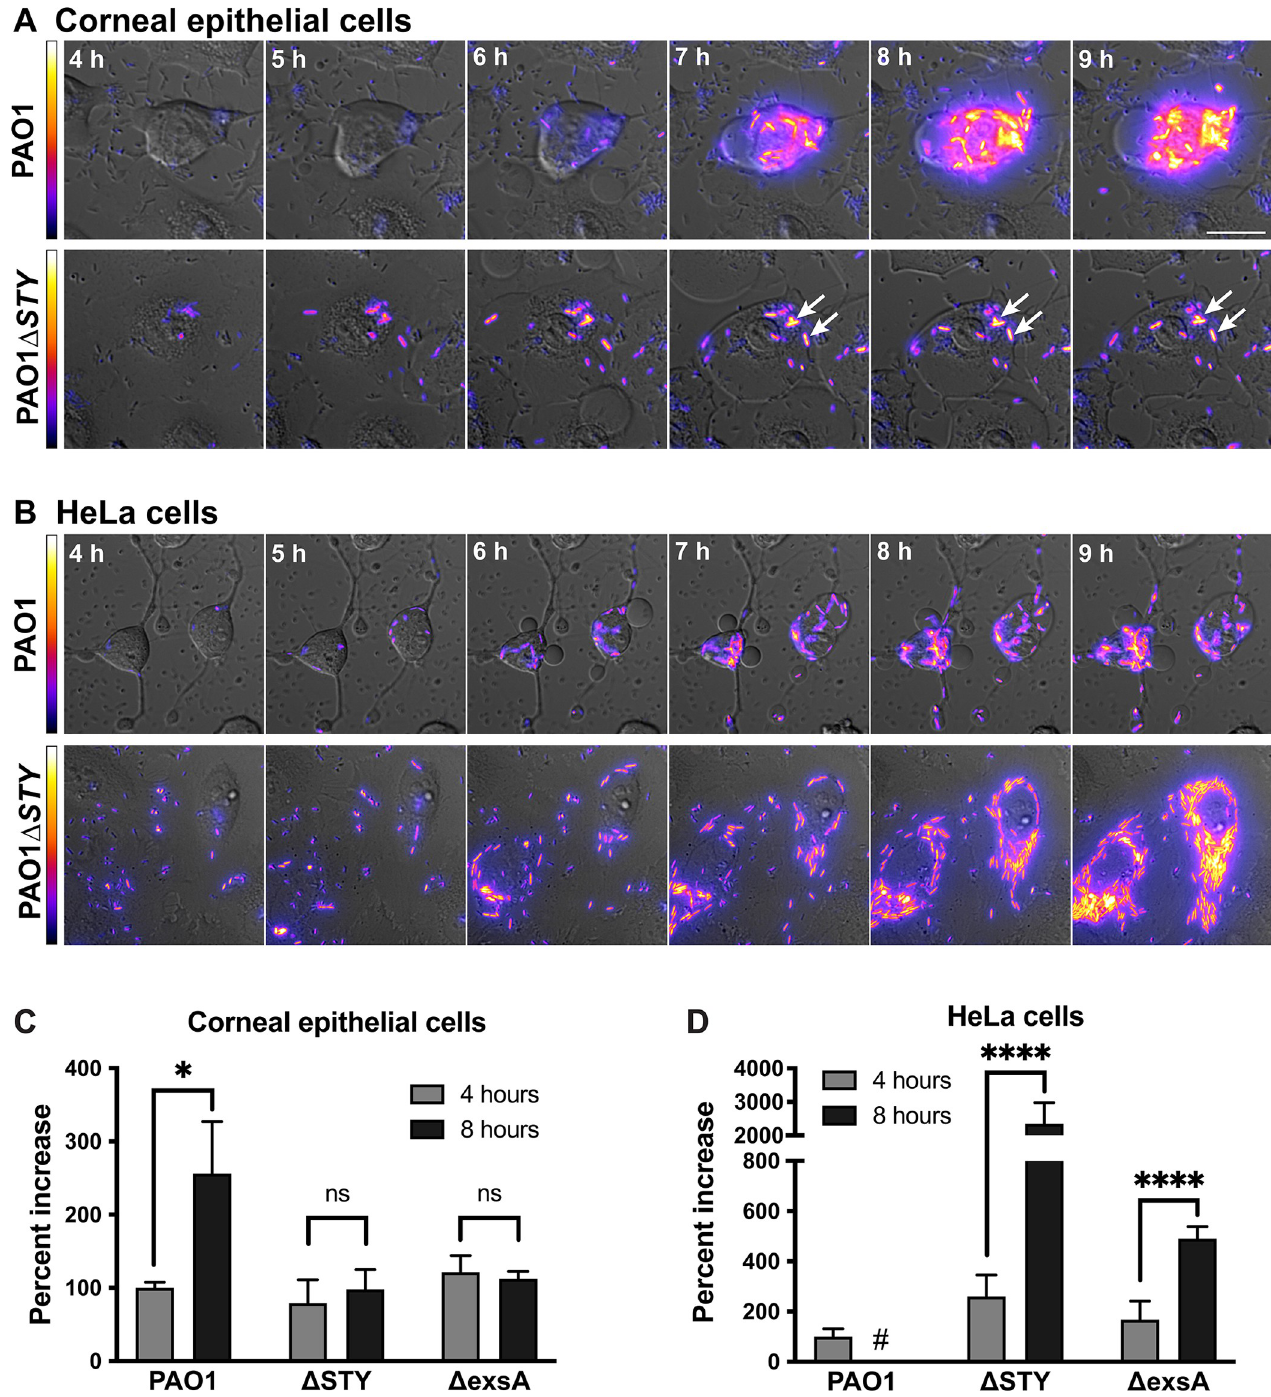
Fig 2. Corneal epithelial cells, but not HeLa cells, limit intracellular replication in the absence of type three effector toxins. Corneal epithelial cells ( hTCEpi) (A) or HeLa (B) cells were infected with PAO1 or PAO1 Δ exoSTY expressing the T3SS-GFP reporter (pJNE05) for 3 h, then extracellular bacteria eliminated with amikacin. Time-lapse images were captured hourly from 4 to 20 h post-infection. Scale bar = 25 μ m. Arrows indicate stationary bacteria between captured time points. Heat-map shows T3SS-GFP reporter intensity of the bacterial cells. Corneal epithelial cells (C) or HeLa cells (D) were infected with PAO1, PAO1 Δ exoSTY or PAO1 Δ exsA (a T3SS negative control) for 3 h, then extracellular bacteria eliminated with gentamicin. Intracellular bacteria were collected from lysed cells at 4 or 8 h post-infection, and CFU counted by plating dilution series. Data expressed as mean ± SD, � P < 0.05, ���� P < 0.001, ns = not significant, Student’s t-Test. # denotes not performed per cell fragility (see text and S1 Fig).